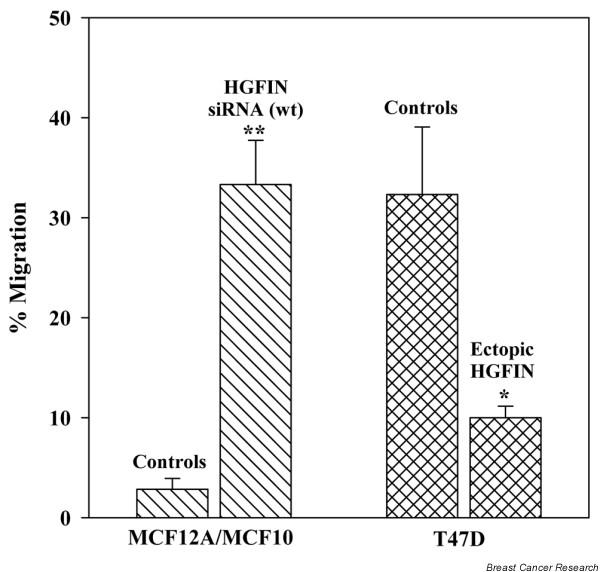
Role of HGFIN in cell migration. MCF12A and MCF10 were knock-out for HGFIN, and T47D were ectopically expressed for HGFIN. All cell types were studied in cell migration assays. Controls were performed with MCF12A and MCF10 as untransfected, vector transfectants or transfectants with HGFIN mutant siRNA. Controls for T47D used untransfected cells or vector transfectants. All values for the control groups were pooled and presented together in single bars. The data are presented as mean ± SD, n = 5.